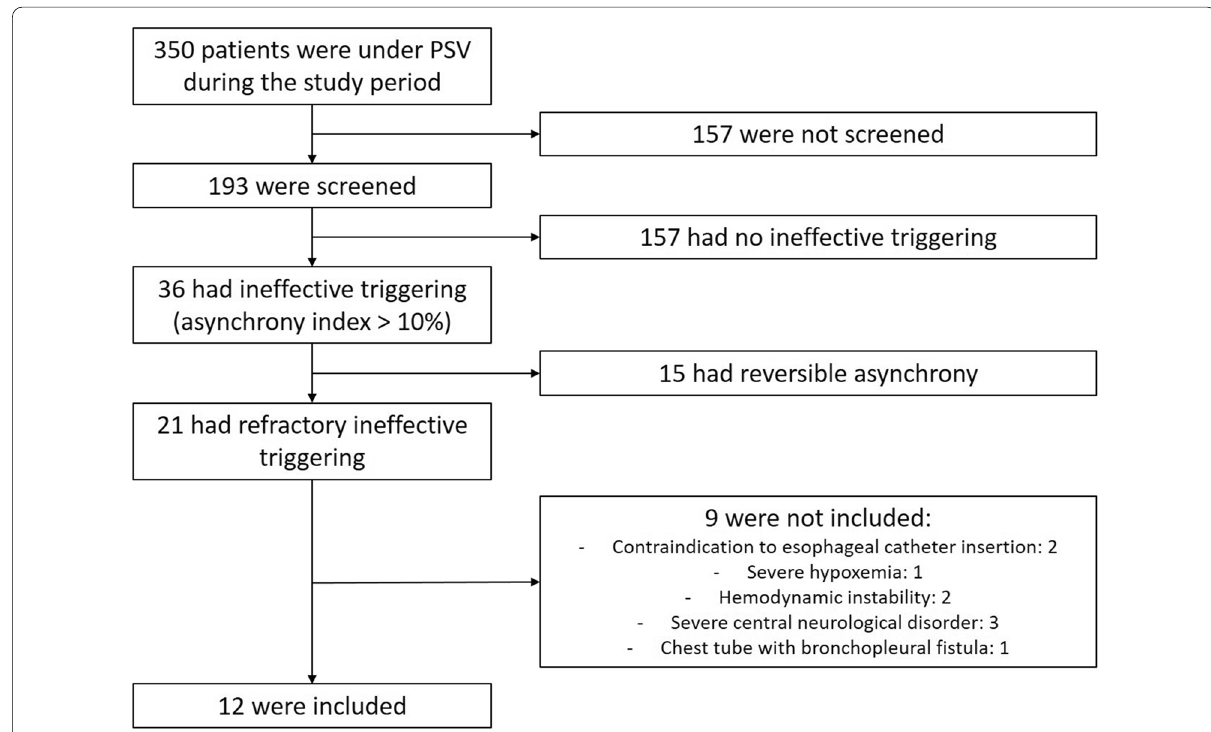
Fig. 1 Flow chart. Flow chart of screening and inclusion. PSV denotes pressure support ventilation